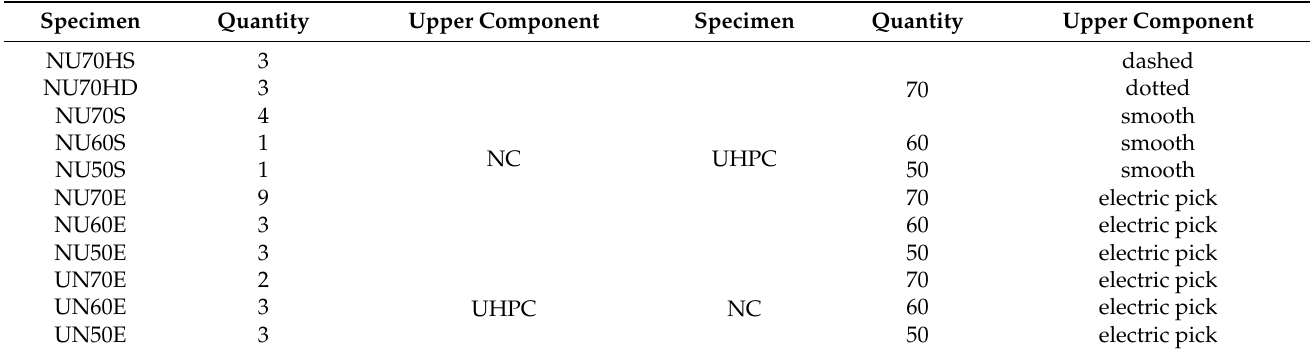
Table 1. Specimens for “improved” slant shear